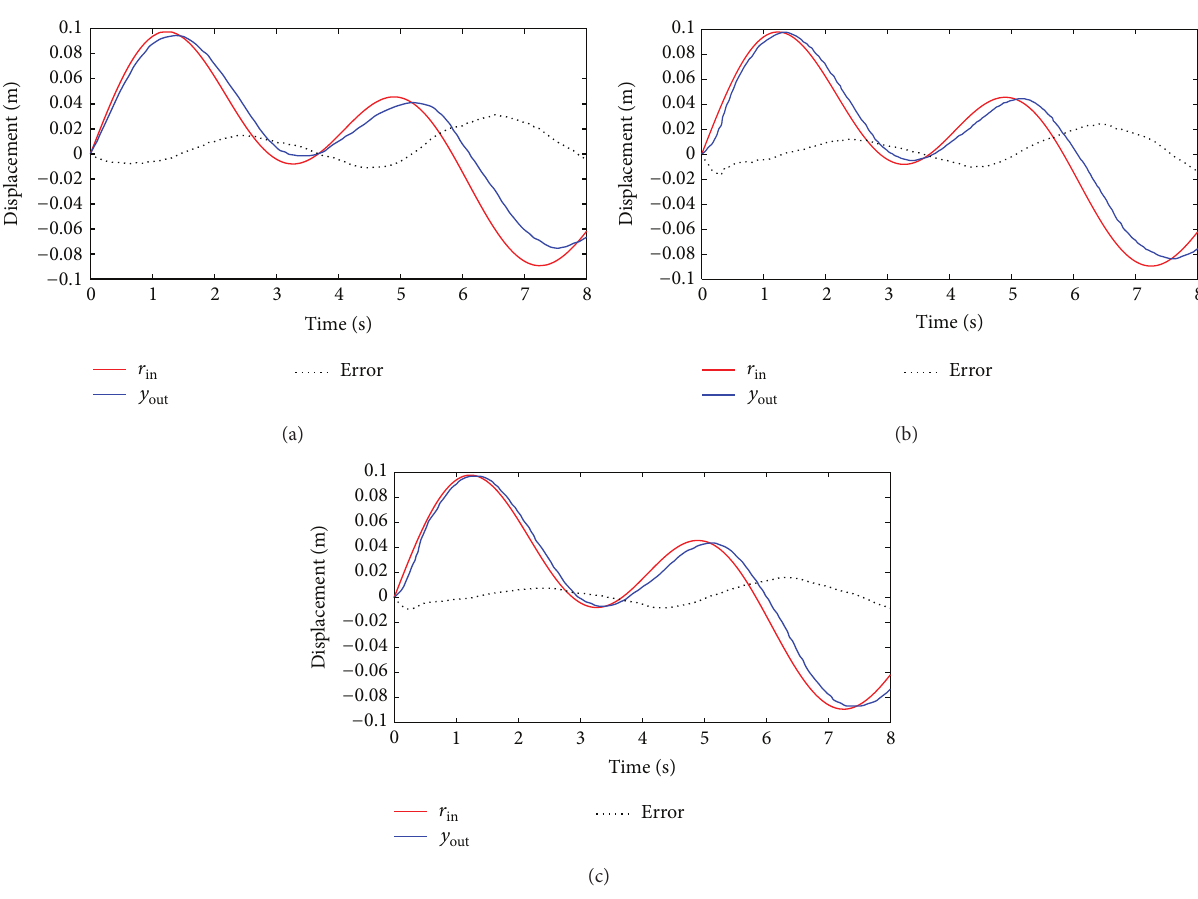
Figure 12: Experimental results for VCAHC of random signal under variable load: (a) PID controller, (b) CMAC-PID controller, and (c) CMAC-PI 𝜆 D 𝜇